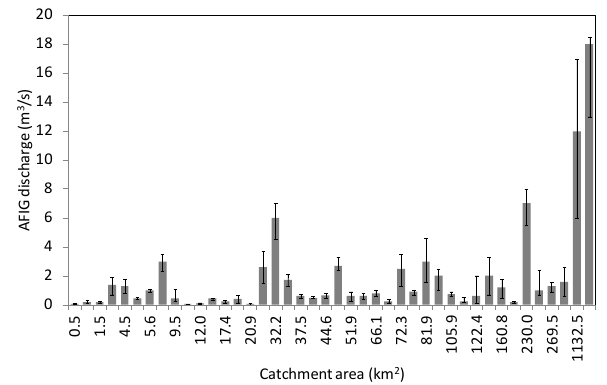
Figure 6. Estimated AFIG discharge (m 3 /s). Error bars represent uncertainty estimate Fig. 6. Estimated AFIG discharge (m 3 s − 1 ). Error bars represent that is associated with water level matching and Manning coefficients. uncertainty estimate that is associated with water level matching and Manning coefficients.